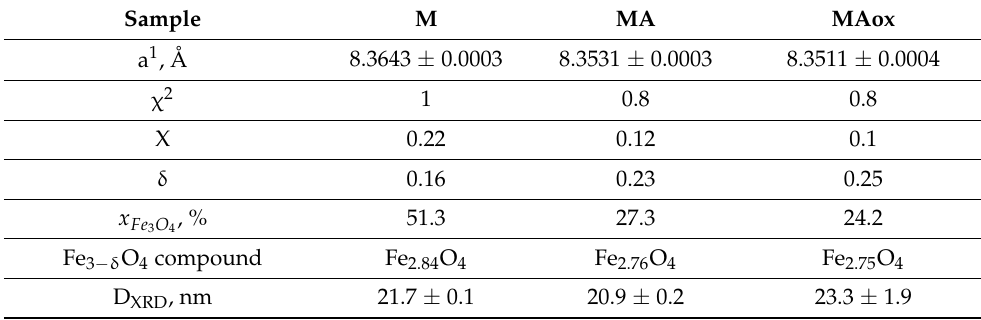
Table 1. Rietveld quantitative analysis and magnetite content